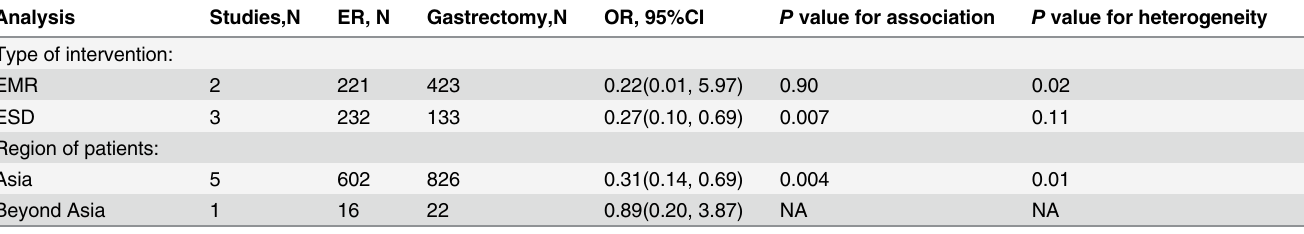
Table 4. Subgroup analyses by the type of intervention and region of